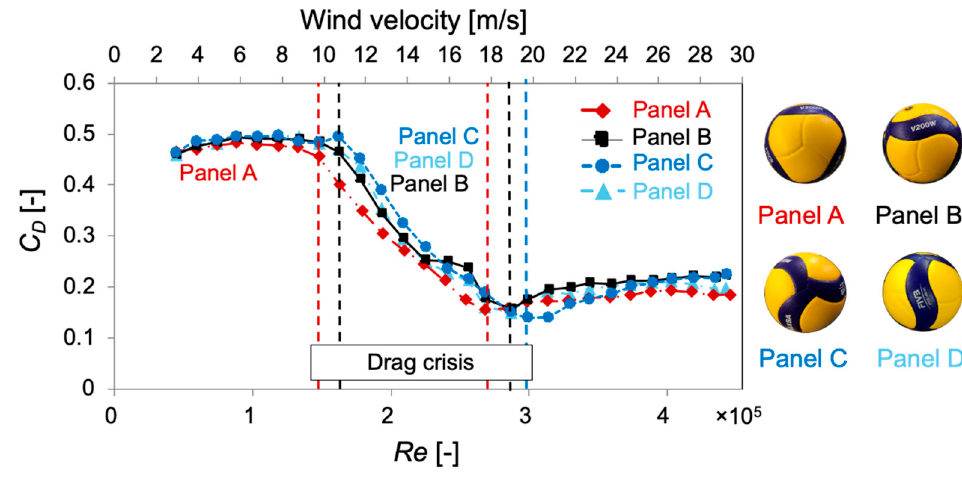
Figure 5. Relationship between Reynolds number and drag coefficient on MVA200.